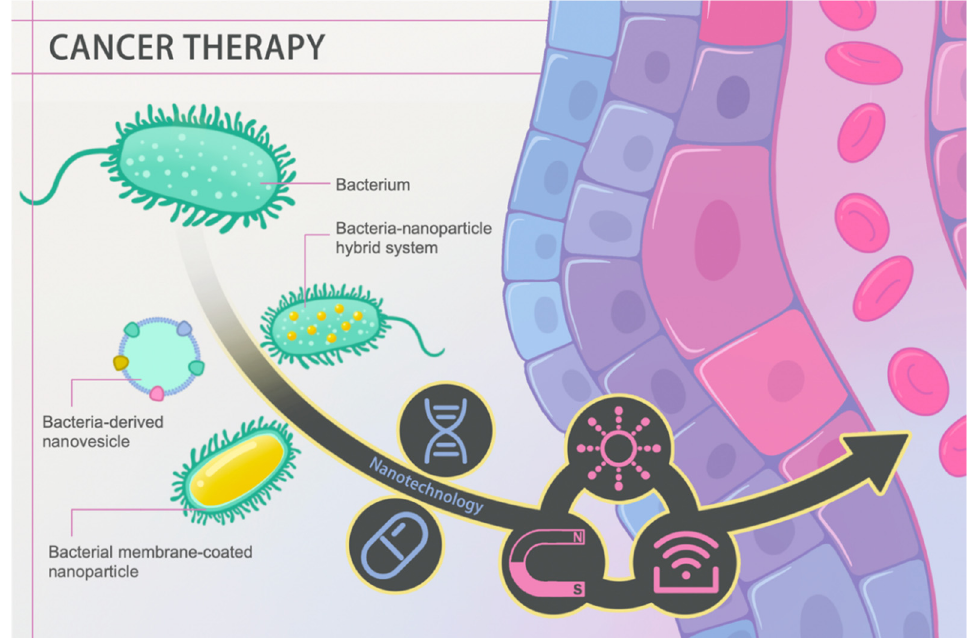
Figure 1. Schematic diagram of nanotechnology-facilitated bacteria-based cancer therapy. Bacteria-derived nanovesicles, bacterial membrane-coated nanoparticles, and bacteria–nanoparticle hybrid systems represent the three main representative delivery platforms used to date. Such platforms not only facilitate drug/gene loading and delivery, but they can also perform diverse functions in response to external stimuli, such as light, magnetism, and ultrasound, achieving better therapeutic efficacy.